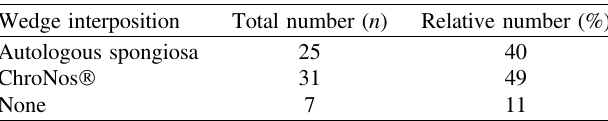
Table 2. The medial wedge was left un fi lled or was reconstructed using bone substitute.